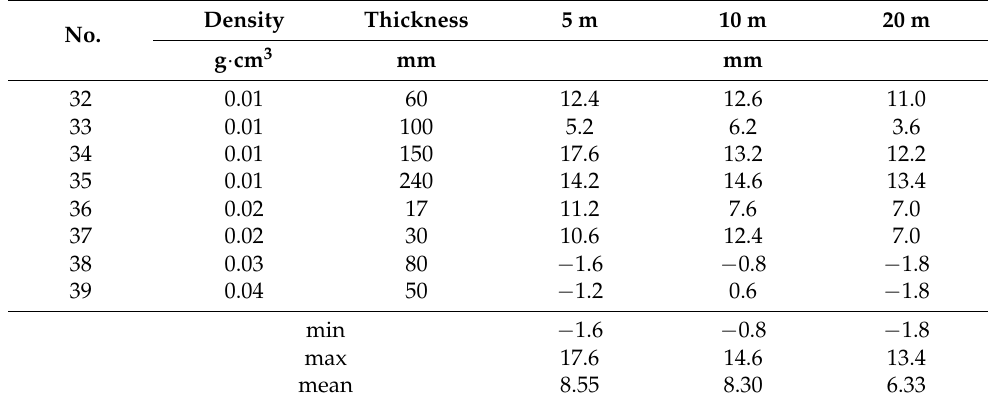
Table 4. Mean values of absolute RL EDM errors on distances: 5, 10 and 20 m to EPS (expanded polystyrene sheets, commonly called Styrofoam; white). Numbers of samples according to Table